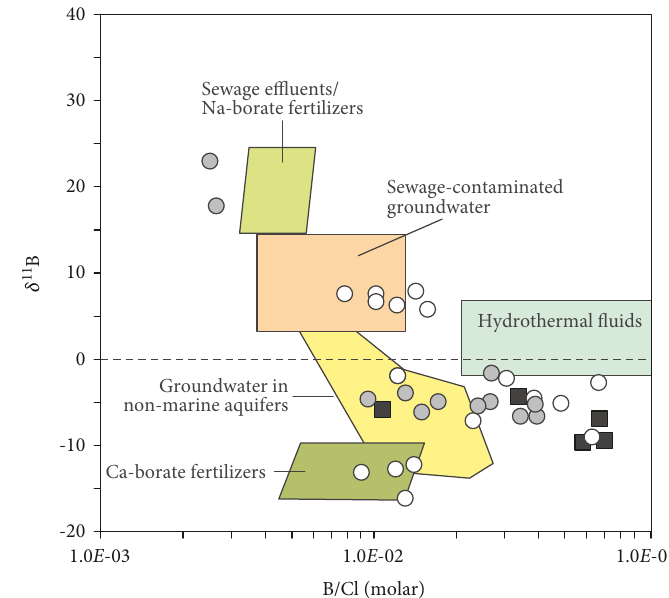
Figure 5: Pattern of typical ranges of δ 11 B and B/Cl values of potential contamination sources, after Vengosh et al. [21]. Symbols are as in Figure